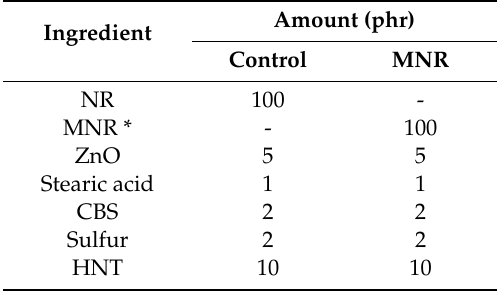
Table 1. Compounding ingredients used in the composites.